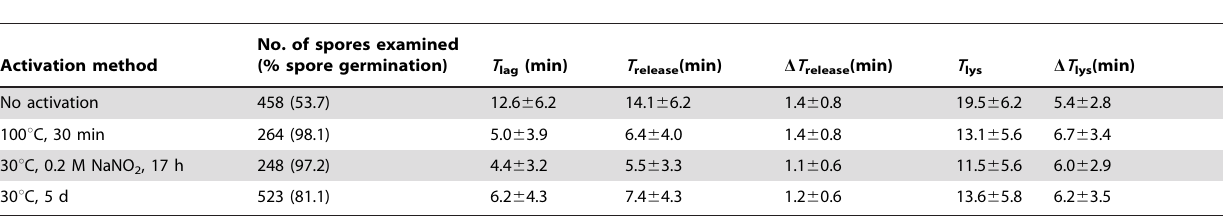
Table 2. Effect of activation methods on G. stearothermophilus spore germination*.